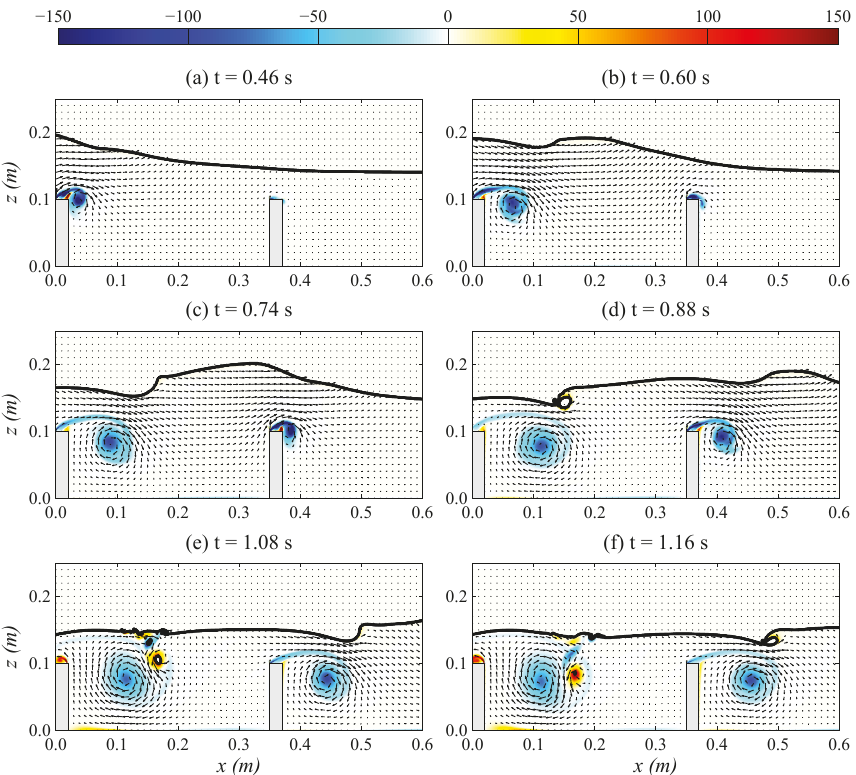
Figure 7. Simulated evolutions of the free surface elevation, velocity and vorticity (unit: s –1 ) (color map) fields for the case of D = 0.35 m at six time instants: ( a ) t = 0.46 s; ( b ) t = 0.60 s; ( c ) t = 0.74 s; ( d ) t = 0.88 s; ( e ) t = 1.08 s; ( f ) t = 1.16 s.